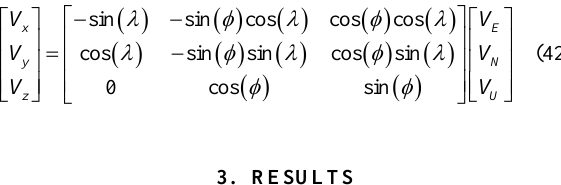
Figure 5. Changes of the cumulative seismic moment in Zagros from 1970 to 2016 and the seismic moment rate. According to the calculations, the seismic moment rate is   which is the estimated to be 18 3.7977*10 Seismic M Nm Year slope of the fitted line in Figure (5). According to the calculations, the geodetic moment rate is estimated to The contribution of the earthquakes to the Zagros deformation is determined by dividing the seismic moment rate to the geodetic moment rate which is about 13.06%. In addition to calculation of the moment rates, the changes of the seismogenic thickness can also be depicted in different parts of the Zagros. Figure (6) depicts the changes of the seismogenic thickness in